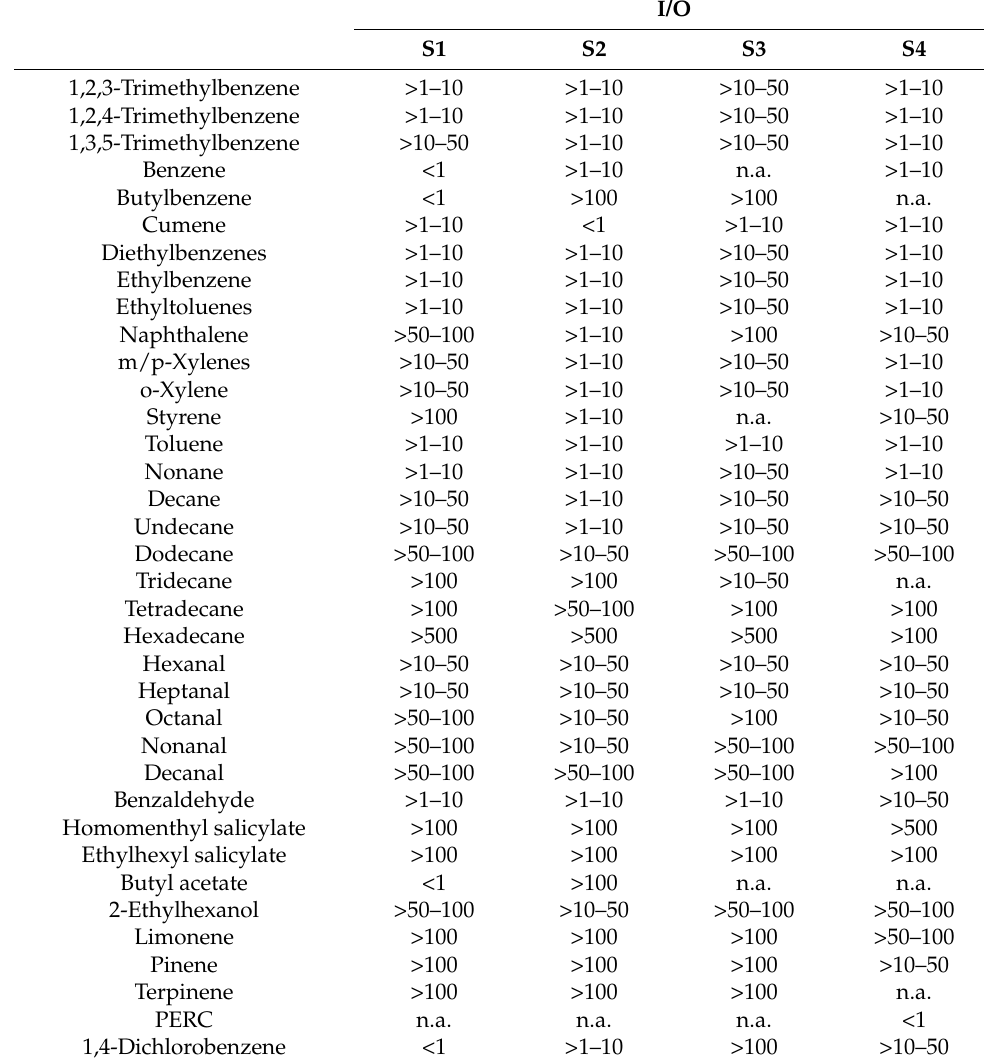
Table 2. Indoor-to-outdoor ratios (I/O) of the